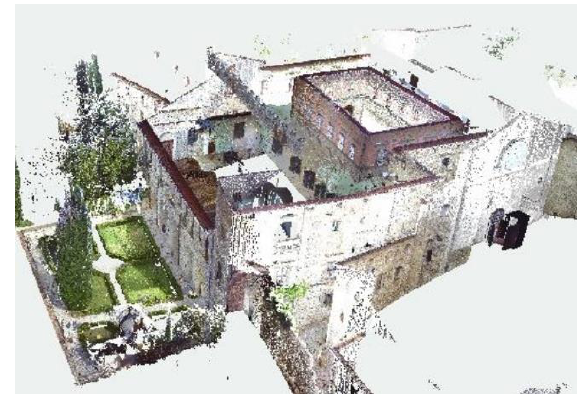
Figure 4 . TLS point cloud